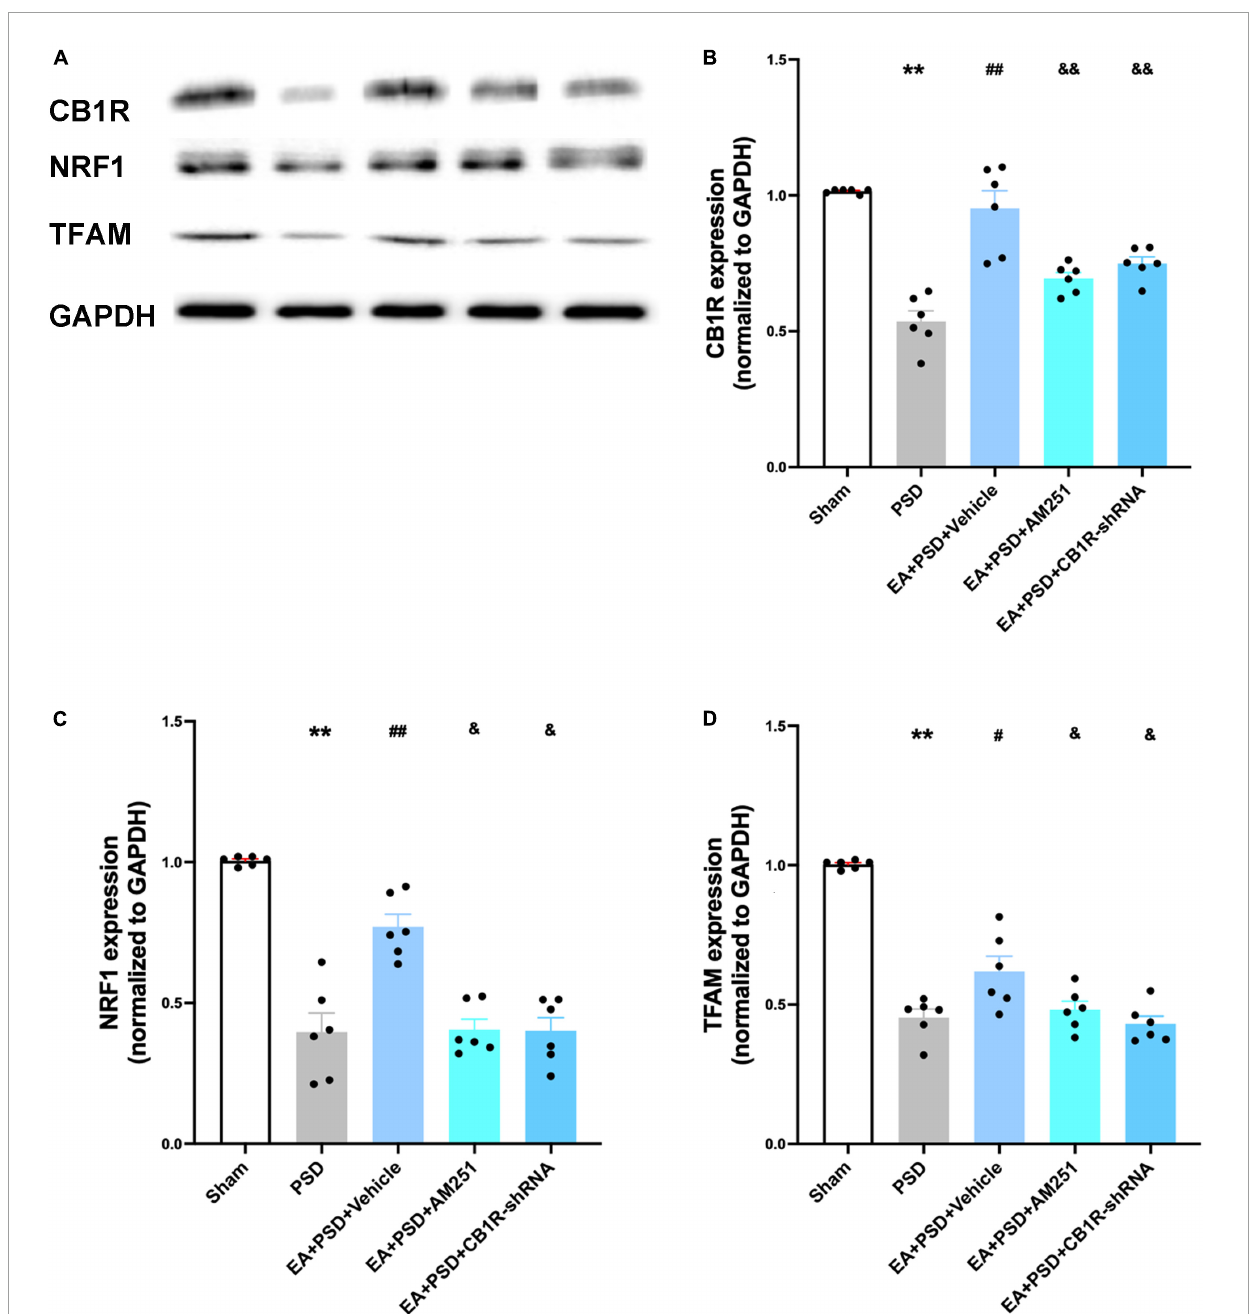
FIGURE7 The increased CB1R and mitochondrial biogenesis proteins induced by EA treatment were abolished by AM251 and CB1R-shRNA supplementation. (A) Representative images of western blots of the CB1R, NRF-1 and TFAM proteins. (B) Quantitative analysis of CB1R protein in hippocamps. (C,D) The level of NRF-1 (C) and TFAM (D) expressed in the hippocampus ( n =6 per group, * P < 0.05, ** P < 0.01 vs. the sham group, # P < 0.05, ## P < 0.01 vs. the PSD group, & P < 0.05, && P < 0.01 vs. the EA